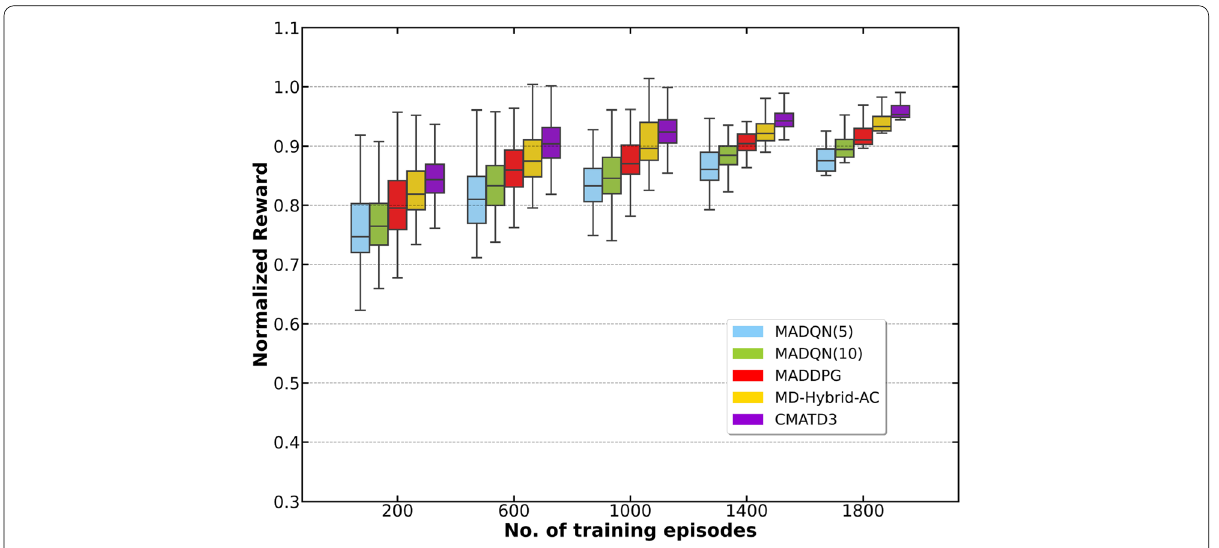
Fig. 7 Normalized reward values obtained during